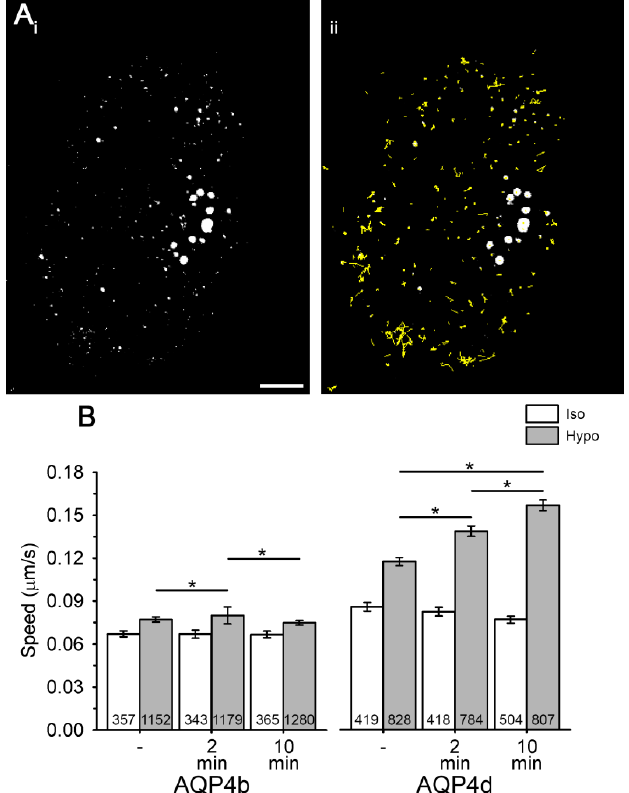
Figure 4. The speed of vesicles carrying recombinant AQP4b and AQP4d increases in hypoosmotic